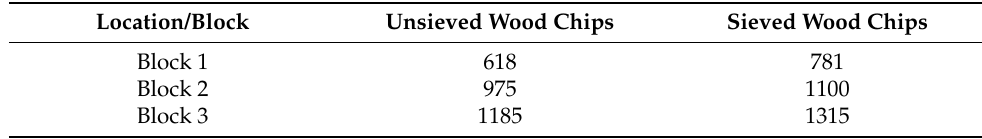
Table 1. Initial volume (m 3 ) of wood chip piles.